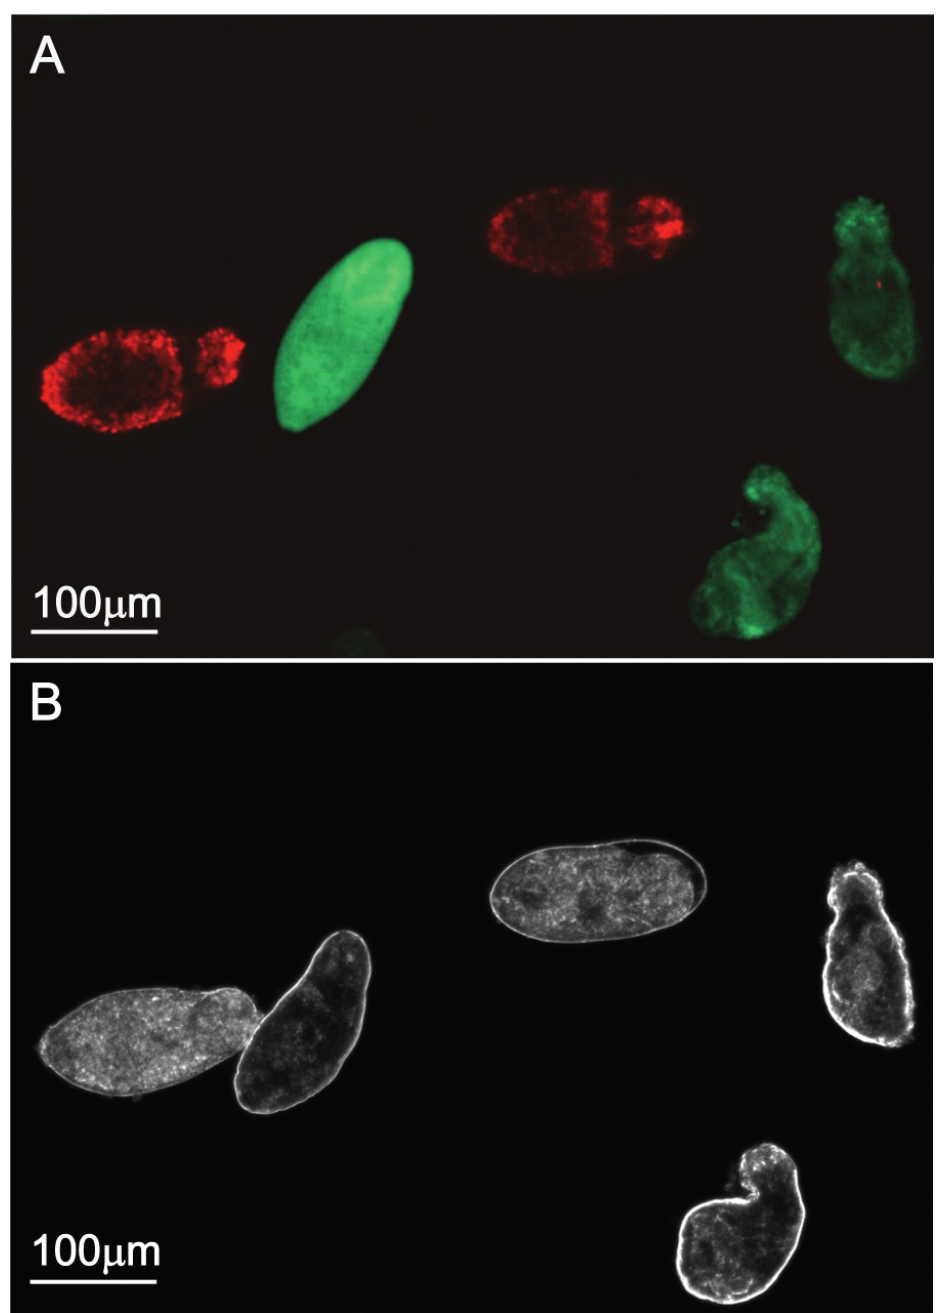
Fig. 1 – Schistosomula viability can be quantified by differential uptake of fluorescein diacetate (FDA) and propidium iodide (PI). Mechanically- transformed schistosomula were prepared, heat-killed (dead) or left untreated (live) and stained with both FDA and PI fluorophores ac- cording to Peak et al. (Peak et al. 2010). Parasite uptake of fluorescent dyes was visualised using an epi-fluorescent microscope equipped with 536 nm (rhodamine, red) and 494 nm (FITC, green) filters, while parasite morphology was examined using plane-polarized light. (A) Superimposition of epi-fluorescent spectra collected with both 536nm and 494nm filters showing dead schistosomula stained red (PI posi- tive, FDA negative) and live schistosomula stained green (FDA positive, PI negative), (B) Differential morphology of dead and live schistosomula detected by plane-polarized